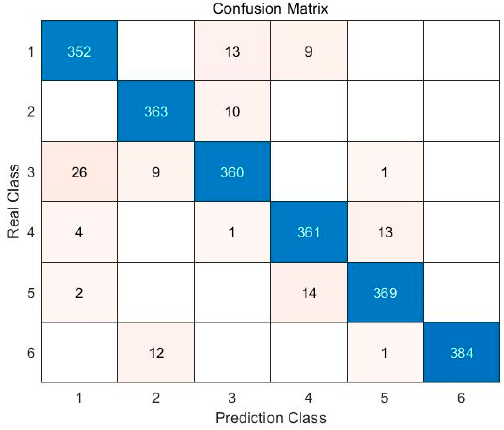
Figure 13. Confusion Matrix.